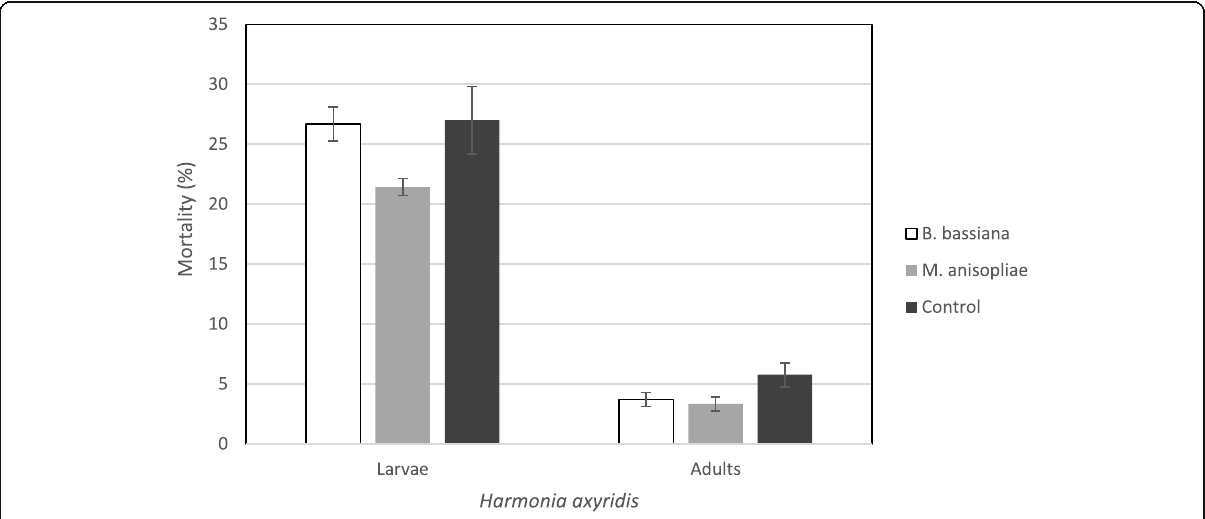
Fig. 2 Mortality percentage of larvae and adults of Harmonia axyridis with entomopathogenic